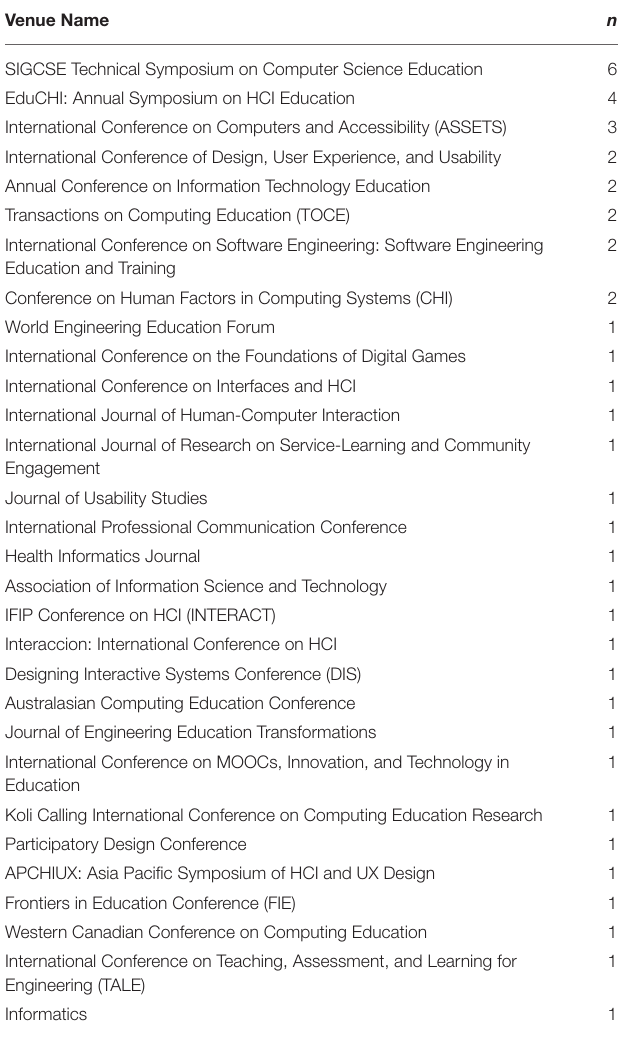
TABLE 2 | A list of journals and conference